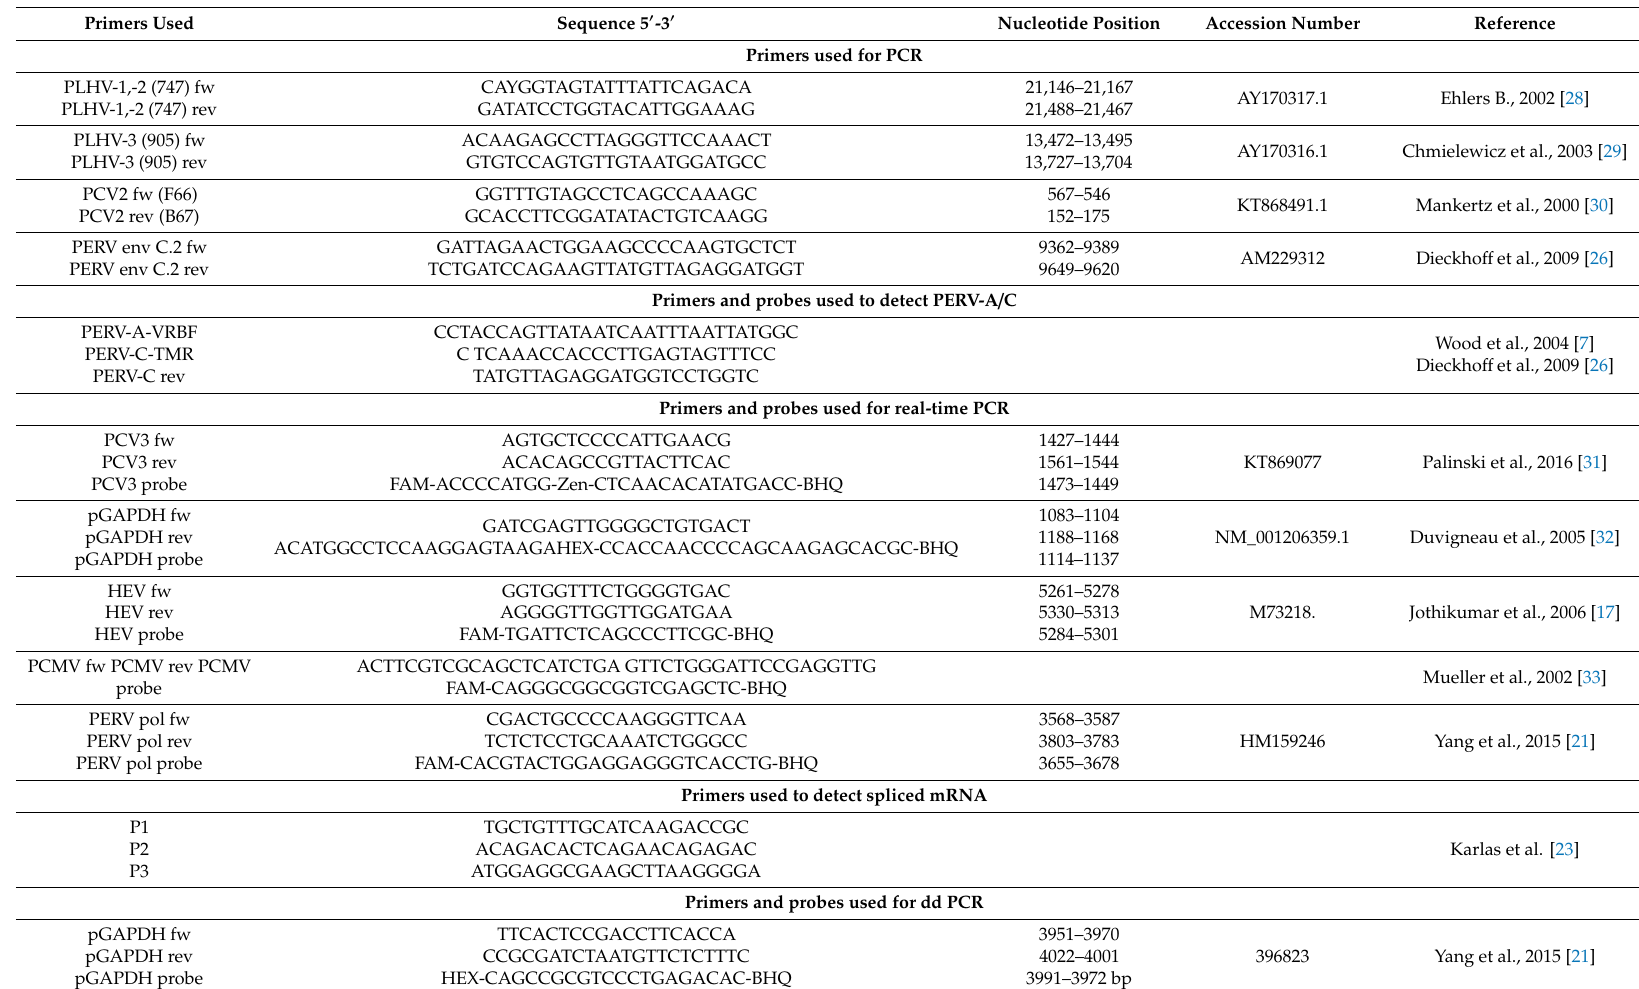
Table 2. Primers and probes used for virus